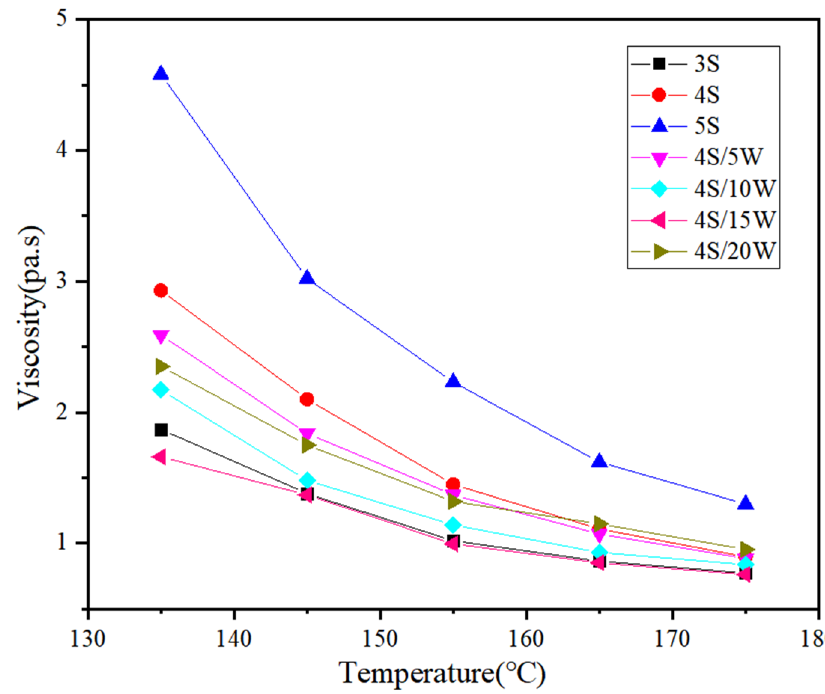
Figure 4. Viscosity of different composite modified asphalts.